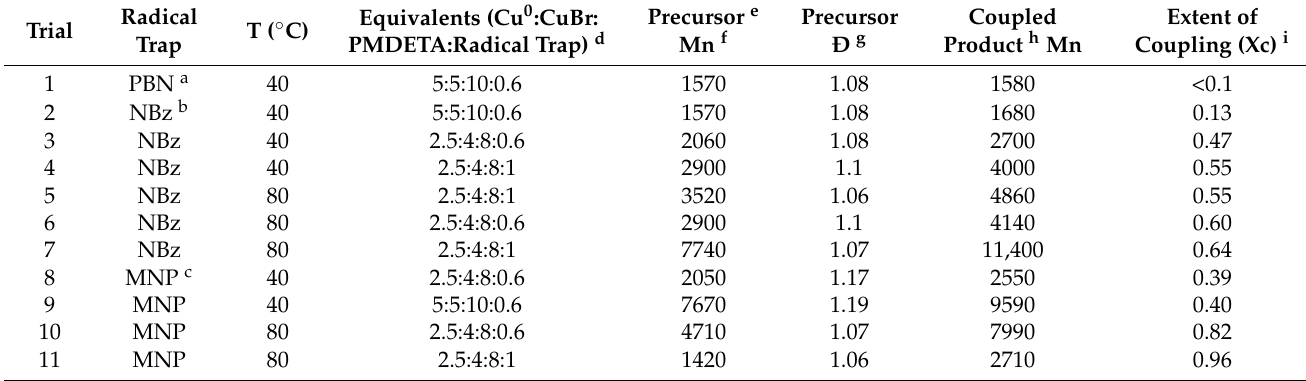
Table 1. Characteristics of PMABr precursors and results of their RTA-ATRC